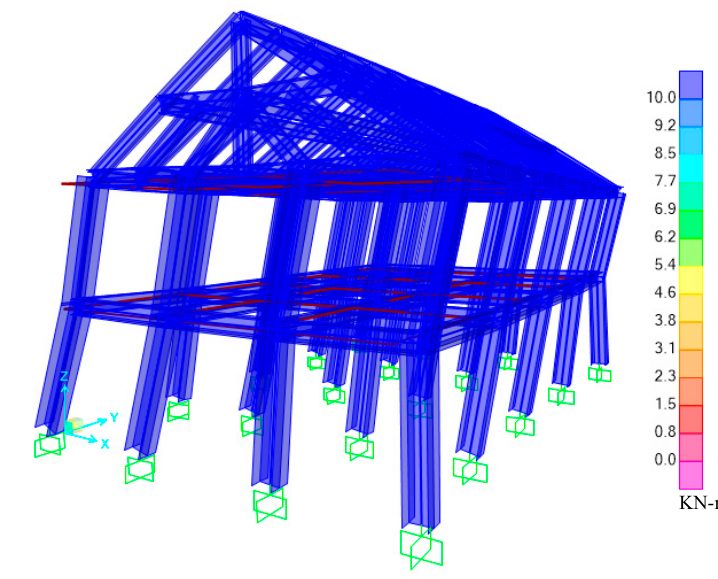
Figure 6. Illustration of the joint system of an Ammatoan vernacular house.